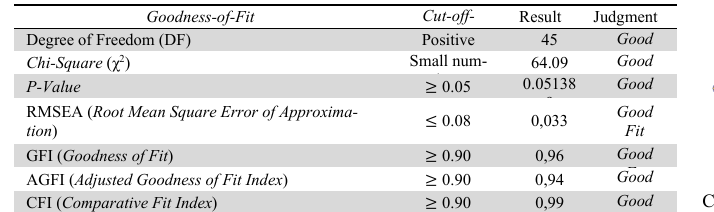
Test Results Overall Model Fit